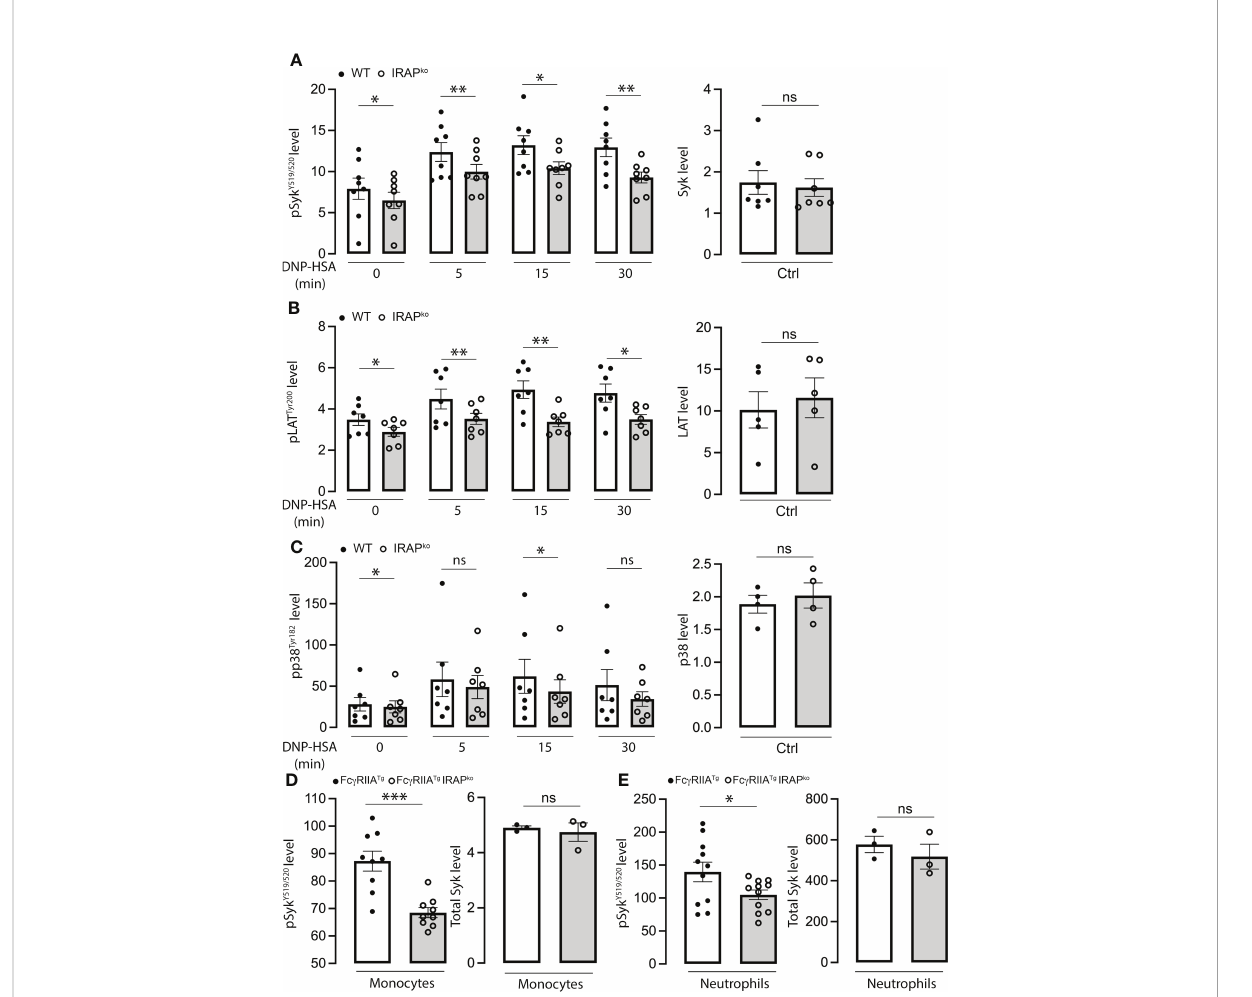
FIGURE 4 Diminished phosphorylation response of signaling effectors in Fc e RI-stimulated BMMCs and IgG stimulated neutrophils and monocytes in the context of IRAP-de fi ciency. (A – C) WT and IRAP-de fi cient (IRAP KO ) BMMCs were sensitized with anti-DNP IgE for 24 hours before